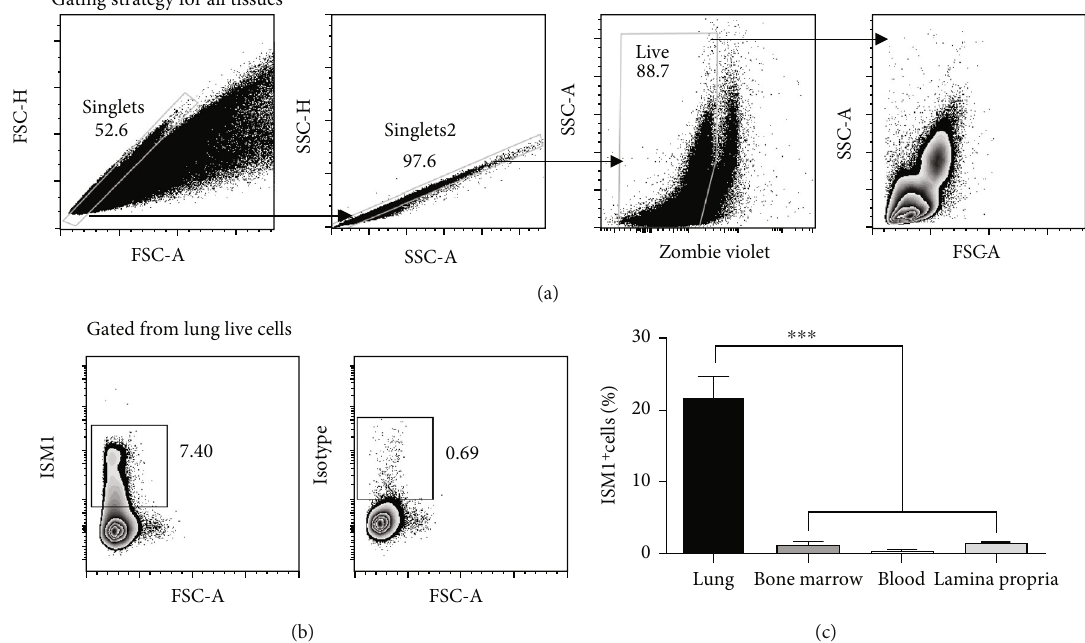
Figure 1: ISM1 + cells are enriched in lung. (a) Living cells were isolated from the tissues described above and were gated as shown. (b) ISM1 + cells from mouse lungs and isotype control are shown. (c) Statistical analysis of the percentage of ISM1 + cells in mouse lung compared with other tissues with lymphoid populations. Data shown are mean plus SEM, n = 7 . Statistical analysis was performed by one-way ANOVA, ∗∗∗ p < 0 : 0001